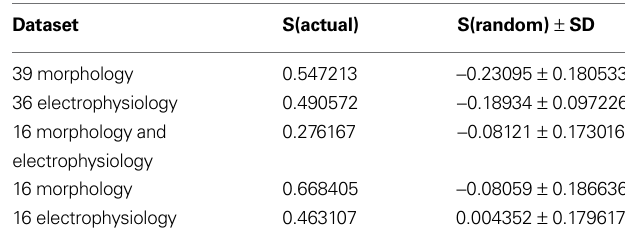
Table 5 | Comparison of silhouette widths of each dataset to the mean silhouette width of 500 trials of clustering randomized